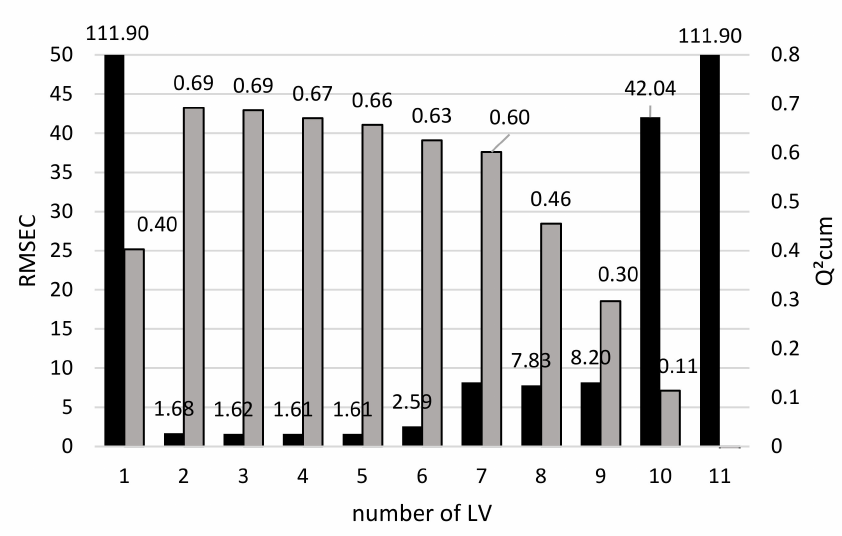
Figure 4. The root mean squared error of cross-validation (RMSEC, black bar) and the Q 2 cum (grey bar) in function of increasing number of latent variables